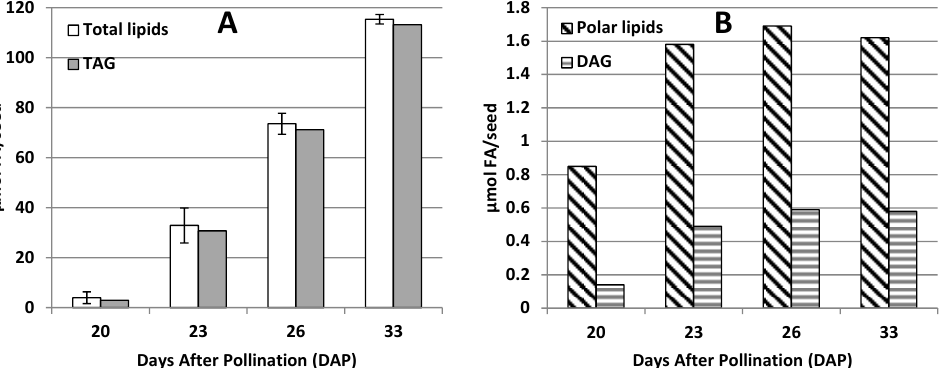
Figure 1. Accumulation of acyl lipids in developing Momordica charantia seeds. ( A ) Total lipids and triacylglycerol (TAG); ( B ) Polar lipids and diacylglycerols (DAG). Mean value and standard deviation ( n ≥ 3) presented in the case of total lipids and mean value for TAG, DAG and polar lipids. Values for TAG, DAG and polar lipids were obtained by multiplication of the mean percentage amount of these lipid classes in total lipids by the mean amount of total lipids (mean values, standard deviations and significant differences between the preceding and the following stage of seed development are presented in Tables S1 and S2).